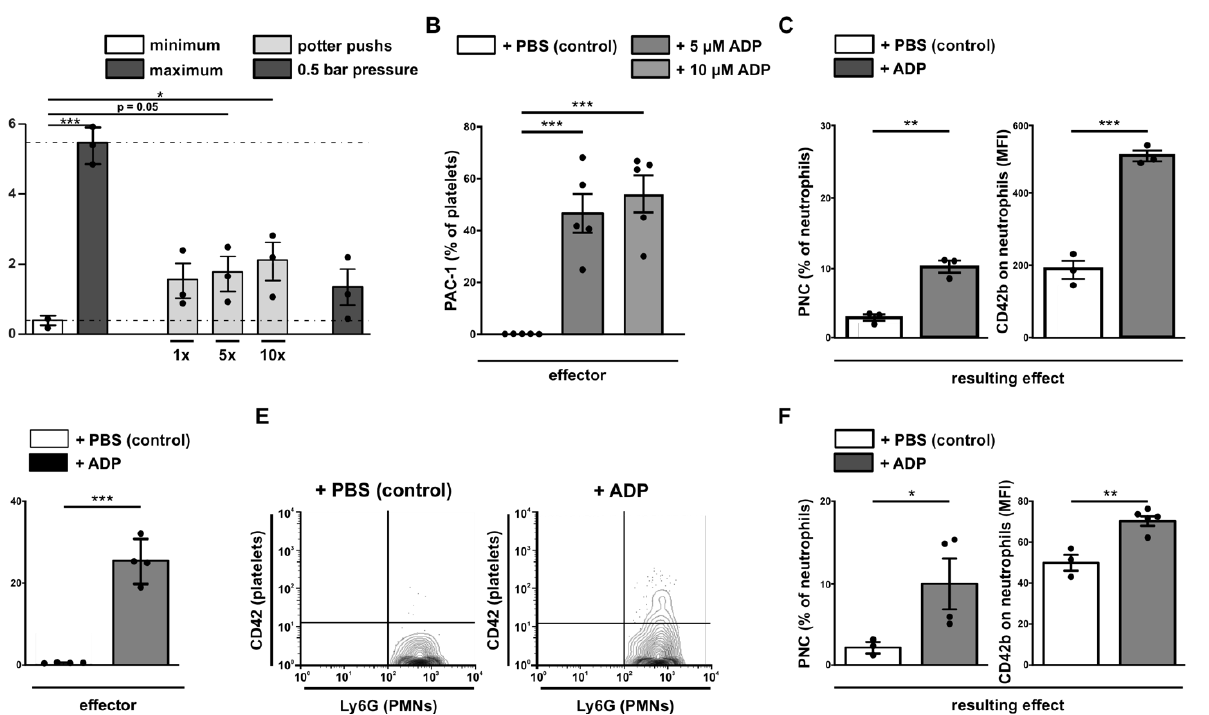
Figure 5. Analysis of initial disturbance and positive feedback loop. ( A ) Measurement of ADP release from human platelets induced by shear stress. Minimum ADP release was induced by centrifugation of platelets with 400 × g , 5 min at RT; maximum ADP release was measured after sonication with 50% power for 10 s. Shear stress induction was generated with a Potter-Elvehjem (1 × —one passage, 5 × —five passages, 10 × —ten passages) or with a pressure of 0.5 bar. ( B ) Human platelets were incubated with ADP (5 and 10 µ M) (grey bars) and activation of GPIIb/IIIa was measured with PAC-1-binding and is depicted as percentage of PAC-1 positive platelets with respect to isotype control (one representative histogram is shown in Figure A5A). ( C ) Human neutrophils in whole blood samples were gated for size (FSC) and granularity (SSC-A). ADP-induced platelet–neutrophil complex (PNC) formation in human whole blood depicted as percentage of CD42b positive neutrophils (left panel) and by the platelet specific marker CD42b mean fluorescence intensity (MFI) measured on the surface of neutrophils. ( D ) Murine whole blood was analyzed accordingly using murine GPIIb/IIIa activity-specific JON/A antibodies and is depicted as percentage of platelets. ( E ) Representative contour plots for unstimulated and ADP-stimulated measurements. ( F ) Murine neutrophils in whole blood samples were gated for granularity (SSC-A) and Ly6G. ADP-induced platelet–neutrophil complex (PNC) formation in murine whole blood depicted as percentage of CD42b positive neutrophils (left panel) and by the platelet specific marker CD42b mean fluorescence intensity measured on the surface of neutrophils (right panel; corresponding histograms are depicted in Figure A5B–F). n ≥ 3; one-way ANOVA with Tukey’s multiple comparisons test for ( A , B )